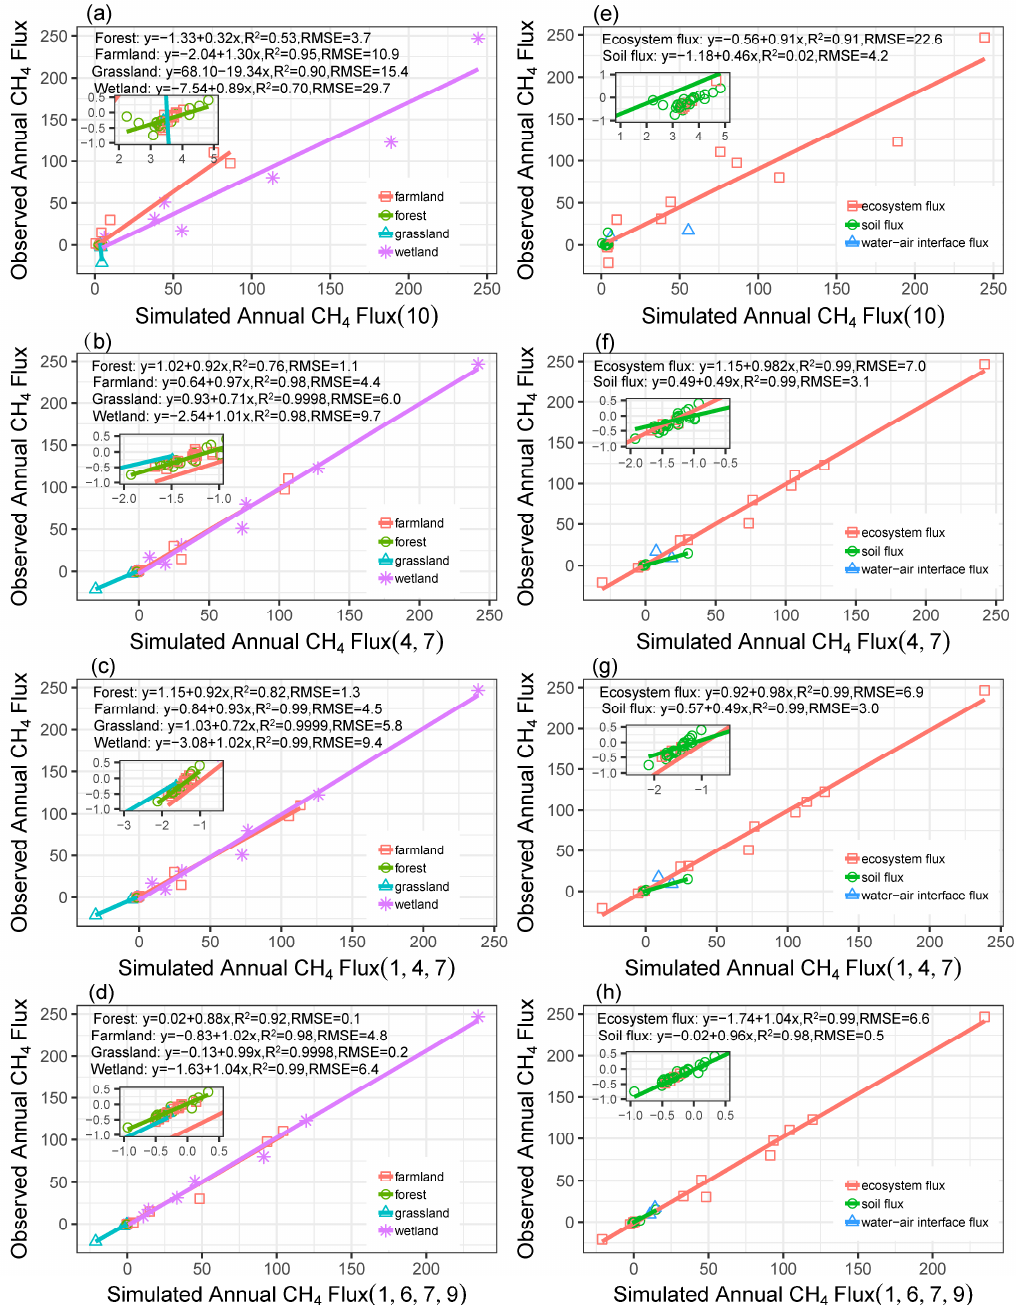
Figure 7. Comparison of the observed and estimated annual CH 4 fluxes using 1 to 4 monthly fluxes of different types of ecosystem ( a – d ) and interface ( e – h ). Derived using Equations (B5)–(B8) in Table 3 and test data (not used in equation development). The small plots on the left are the enlarged portions of the small fluxes. Flux and RMSE unit: g CH 4 m − 2 yr − 1 . The sample size of water–air interface flux was only 2, therefore no regression line and RMSE values were presented.